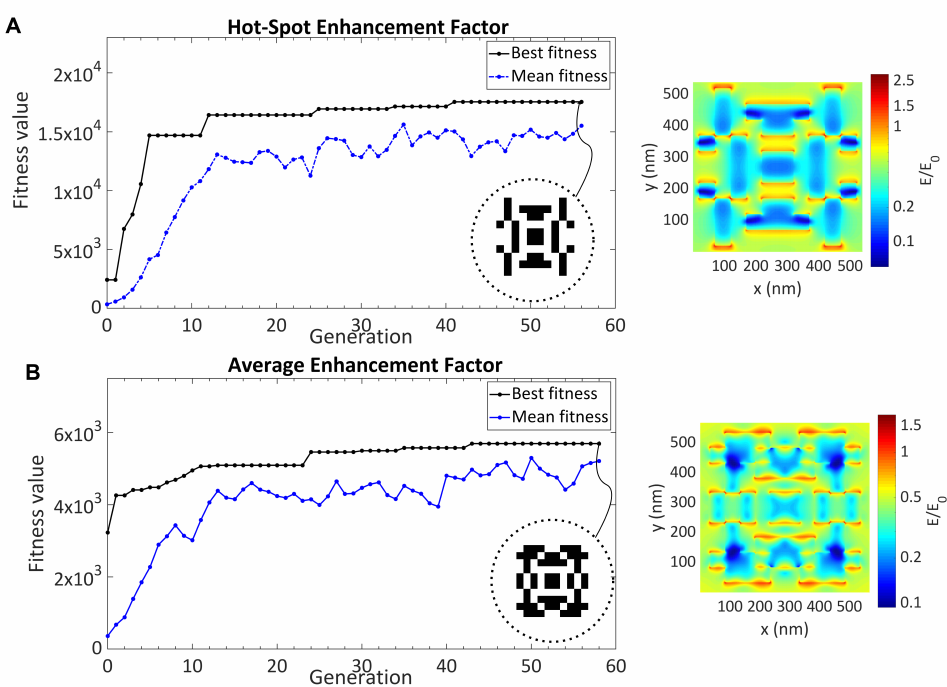
Figure 4. The optimization of the surface-enhanced Raman spectroscopy (SERS) substrate with the genetic algorithm (GA). ( A ) Optimization results using the hot-spot enhancement factor. ( B ) Opti- mization results using the average enhancement